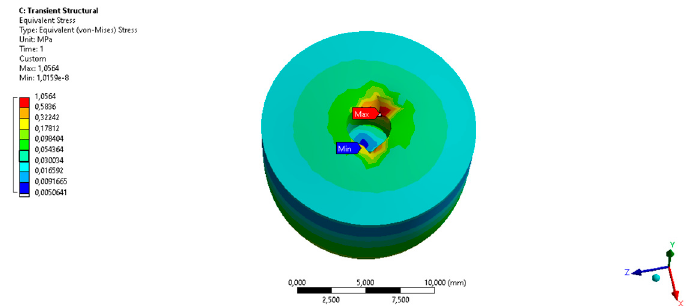
Figure 8. Thermal-Structural Analysis. Equivalent Stress 1.056 MPa.